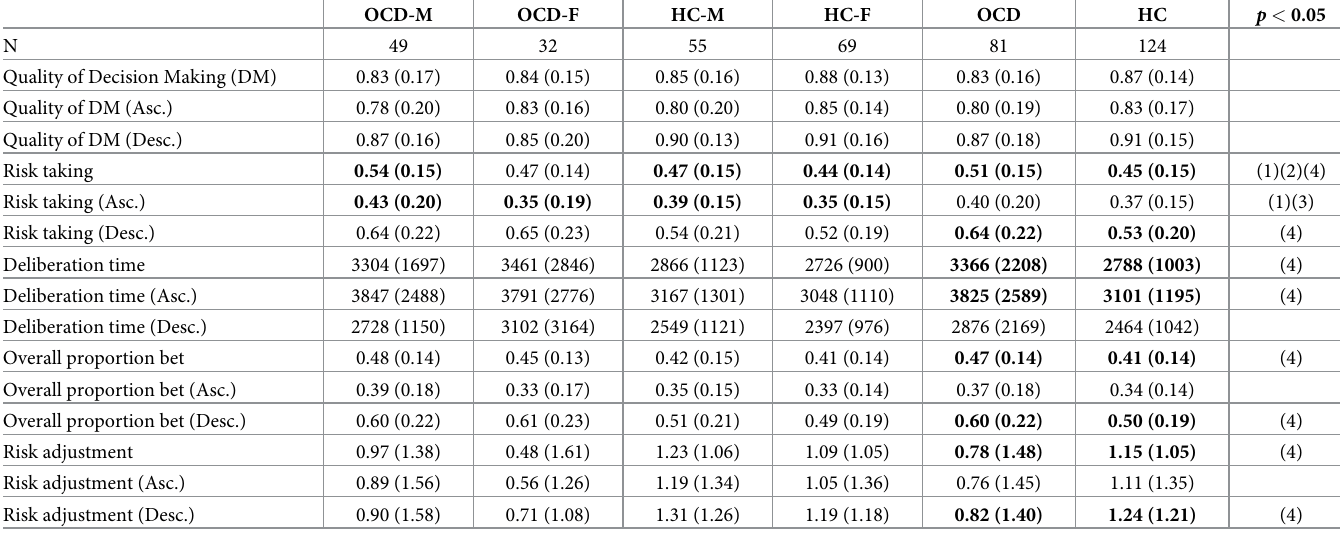
Table 2. Neuropsychological variables in OCD patients and HCs by sex (M,F). Means (standard deviations in parentheses). (1): OCD-M vs. HC-F; (2): OCD-M vs. HC-M; (3): OCD-F vs. HC-M; (4): all OCD vs. all HC (note: the p-values p are unadjusted).